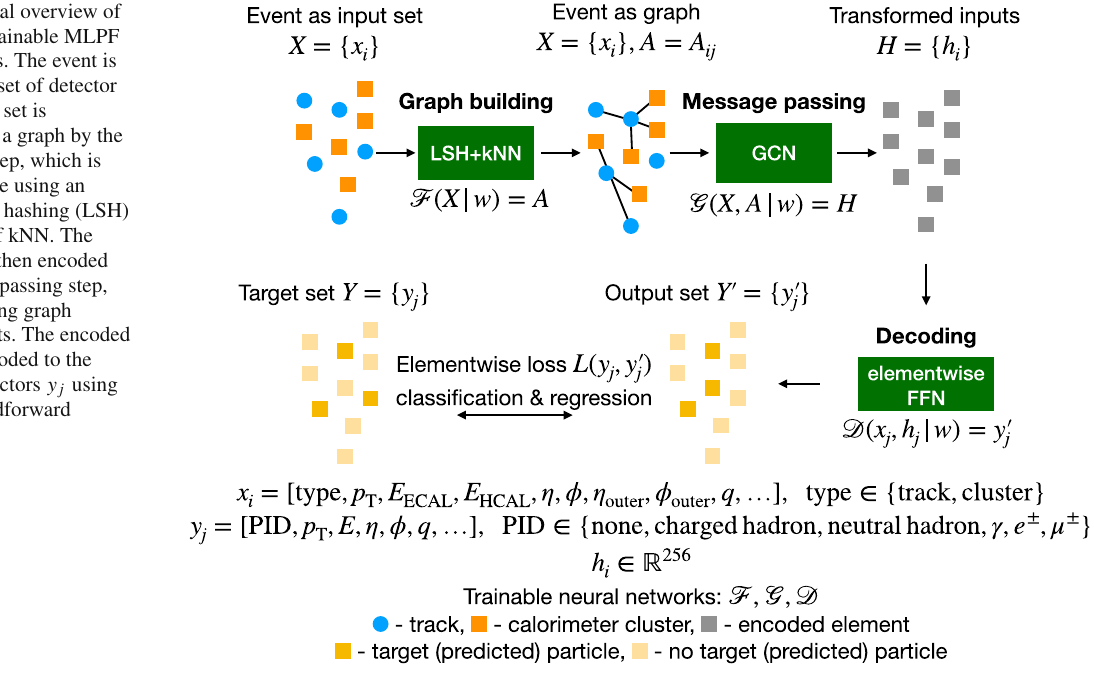
Fig. 3 Functional overview of the end-to-end trainable MLPF setup with GNNs. The event is represented as a set of detector elements x i . The set is transformed into a graph by the graph building step, which is implemented here using an locality sensitive hashing (LSH) approximation of kNN. The graph nodes are then encoded using a message passing step, implemented using graph convolutional nets. The encoded elements are decoded to the output feature vectors y j using elementwise feedforward networks